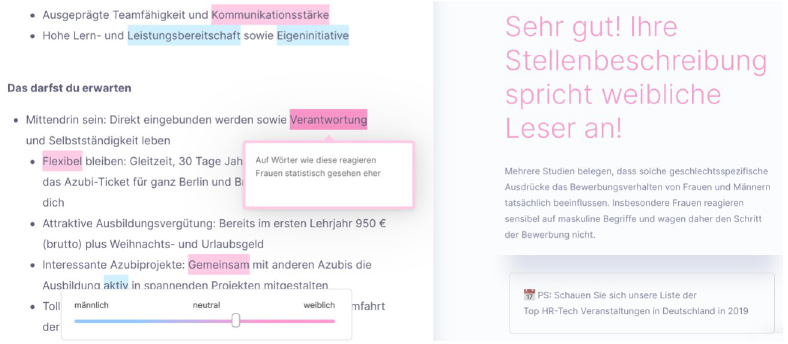
Fig 5. Screenshot of Stafff’s frontend. Feminine words are highlighted in pink, masculine in blue. The slider indicates the gender score for the entire text, and a short text declares that studies show that women are particularly sensitive to masculine